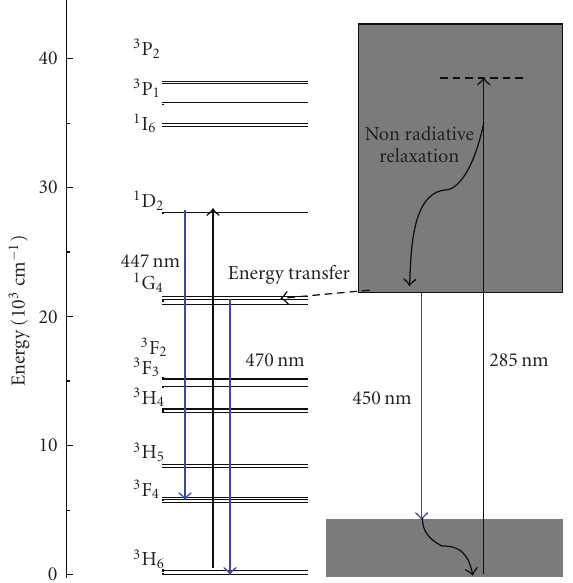
Figure 10: Energy level diagram and luminescence process mecha- nism of Tm 3+ in LiIn(WO 4 ) 2